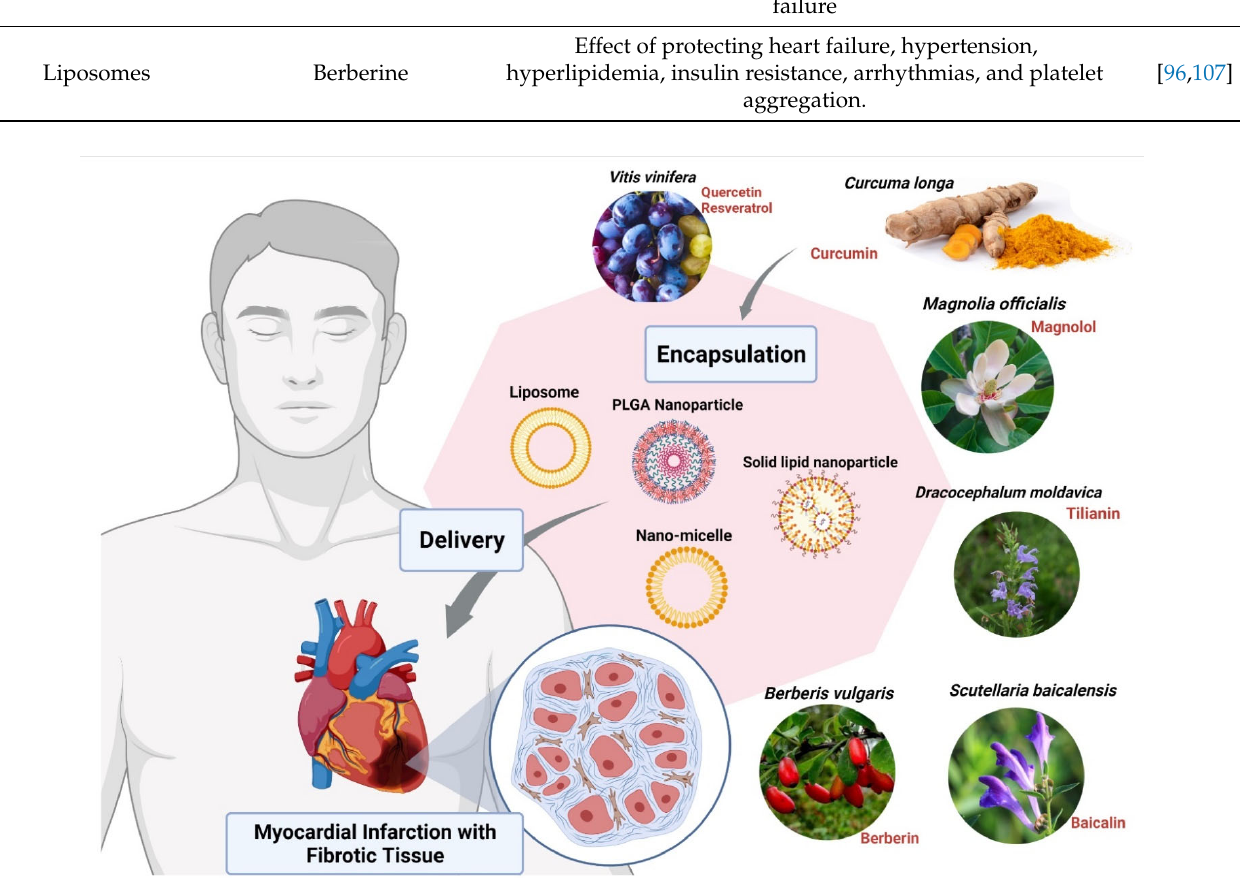
Figure 3. Encapsulation of bioactive compounds with nanoparticles from various herbal extracts to prevent cardiovascular disorders. Abbreviation: PLGA, poly ( D , L -lactic acid-co-glycolic acid). The figure was made with www.biorender.com (access date: 12 January 2022).